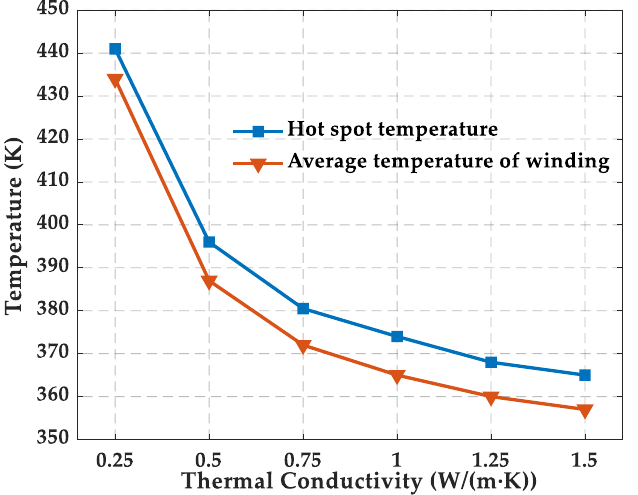
Figure 4. Change of hot-spot temperature and average temperature of winding with the thermal conductivity of epoxy